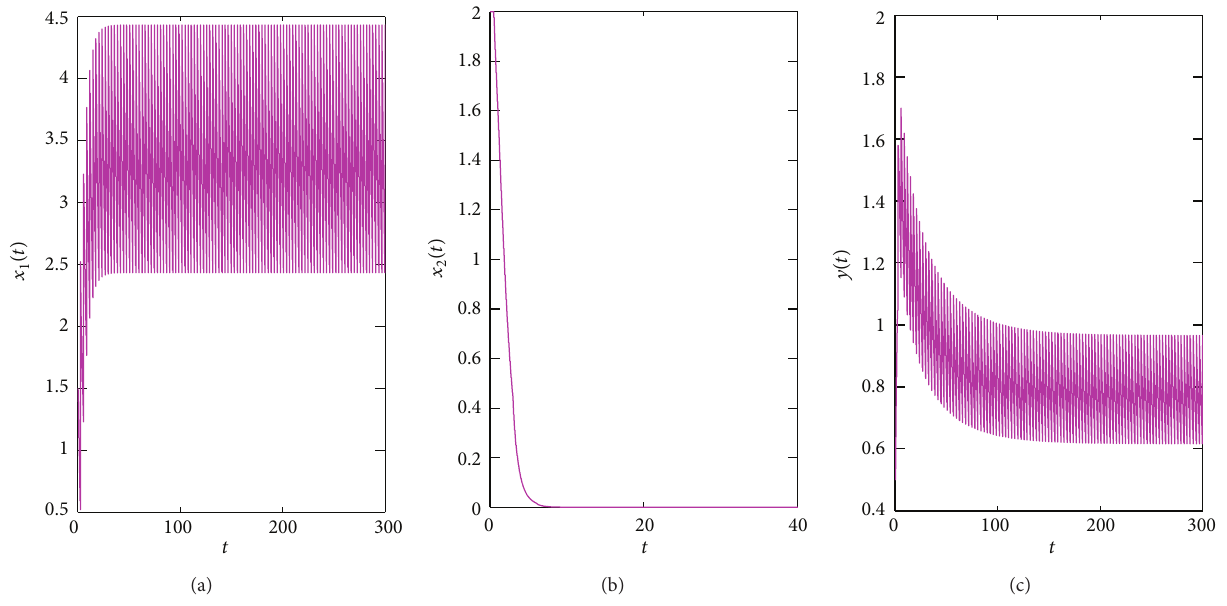
Figure 1: Dynamical behavior of system (1); the parameter values are as follows: 𝑟 = 1.2, 𝜏 = 0.5, 𝜔 = 0.2, 𝛽 = 2,𝜇 = 2,𝑘 = 0.2, 𝑑 1 = 0.1, 𝑑 2 = = 0.15, 𝑝 = 0.1, 𝑝 = 0.5, 𝑎 = 5, 𝑏 = 6 , and 𝑇 = 3 0.2, 𝑑 3 0